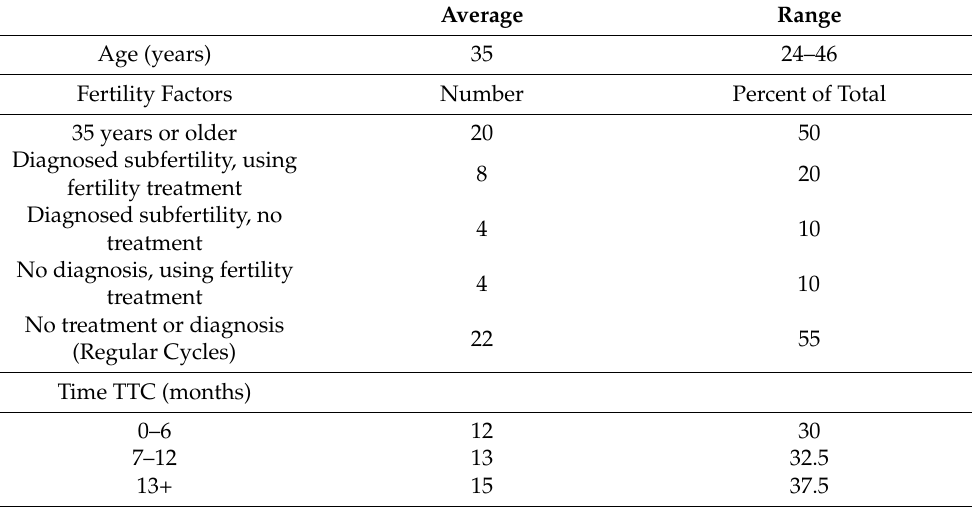
Table 2. Study Participant